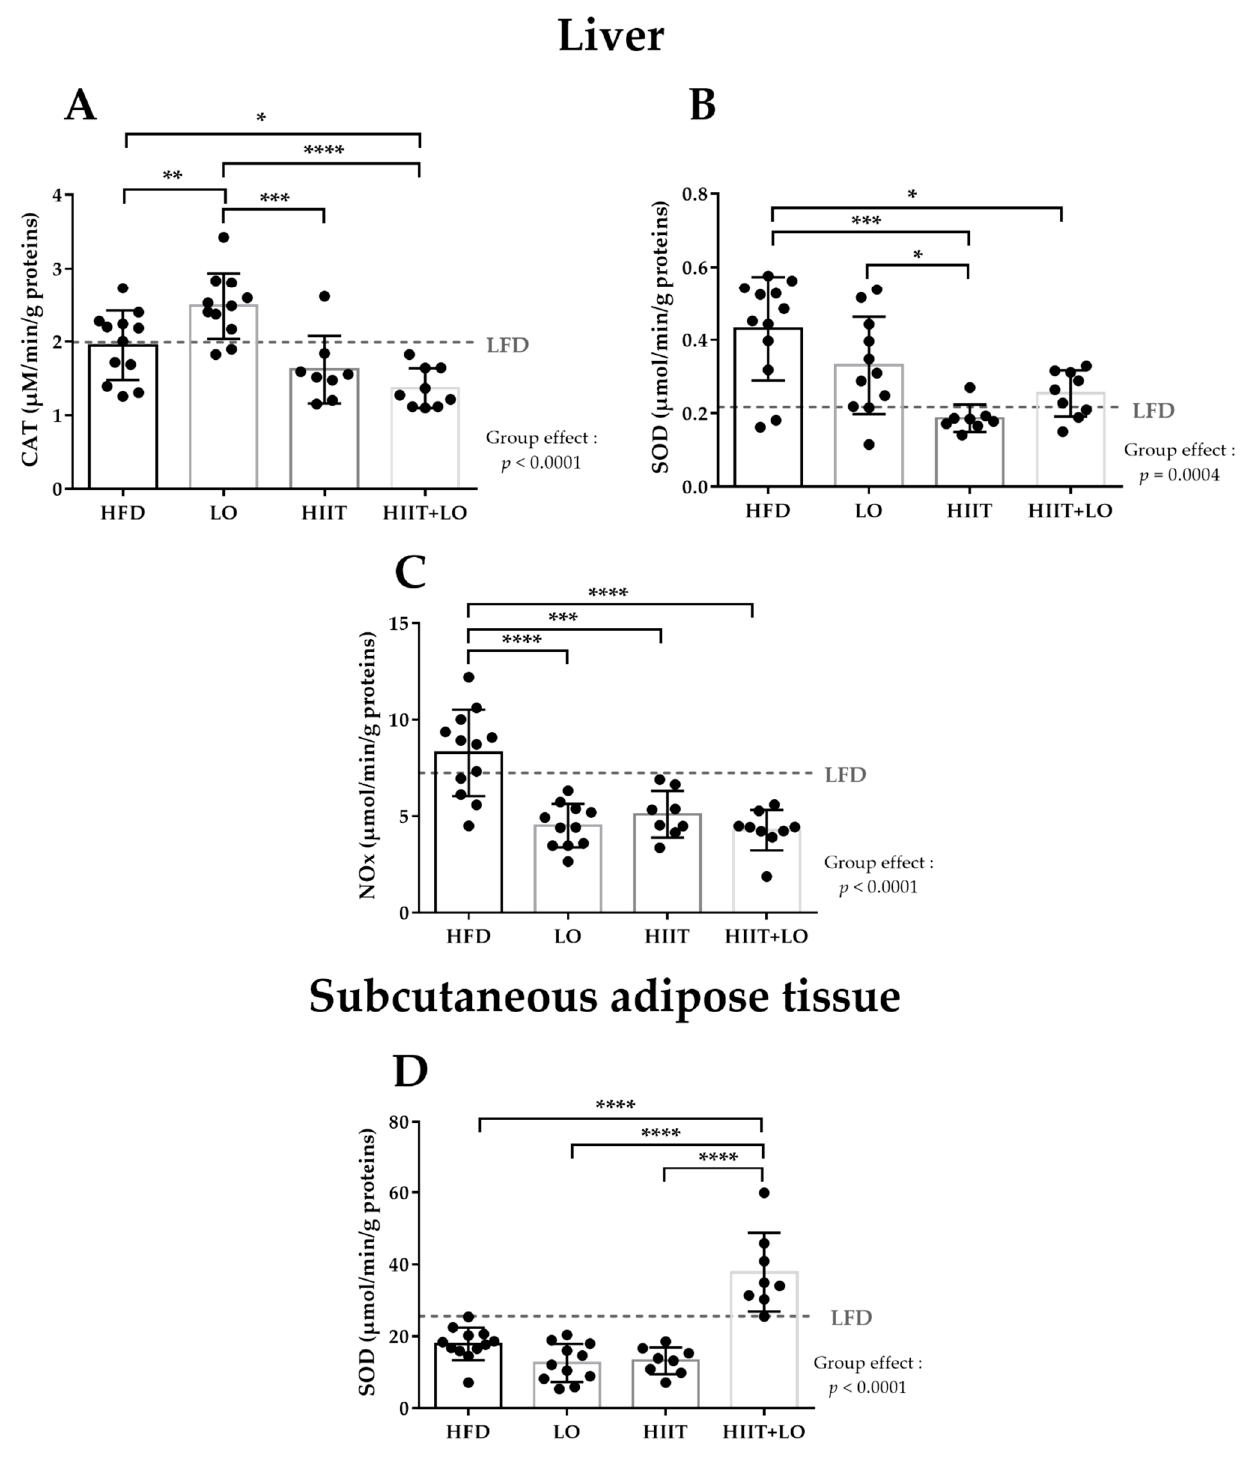
Figure 3. CAT ( A ), NOx ( B ), and SOD activities ( C ) in liver and SOD activity in subcutaneous adipose tissue ( D ) ( µ mol − 1 · min · L − 1 ) in the HFD ( n = 12), LO ( n = 11), HIIT ( n = 8), and HIIT + LO ( n = 9) groups at the end of phase 2 (training and/or LO supplementation for 12 weeks). Data are the mean ± SD. * p < 0.05, ** p < 0.01, *** p < 0.001, **** p < 0.0001 (one-way ANOVA). •: indicates the measured values of the individual rats. CAT: catalase, NOx: NADPH oxidase, SOD: superoxide dismutase, LFD: level observed in rats fed the low fat diet.